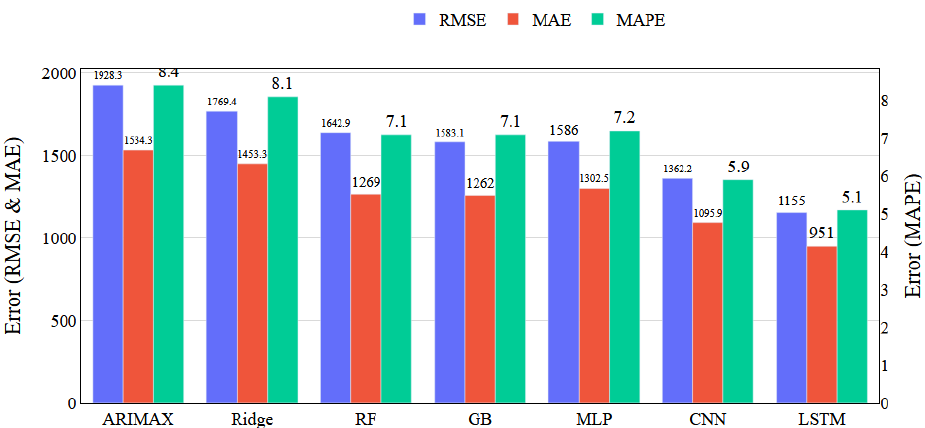
Figure 7. Results of all prediction models without feature selection. RMSE: Root Mean Squared Error; MAE: Mean Absolute Error; MAPE: Mean Absolute Percentage Error.